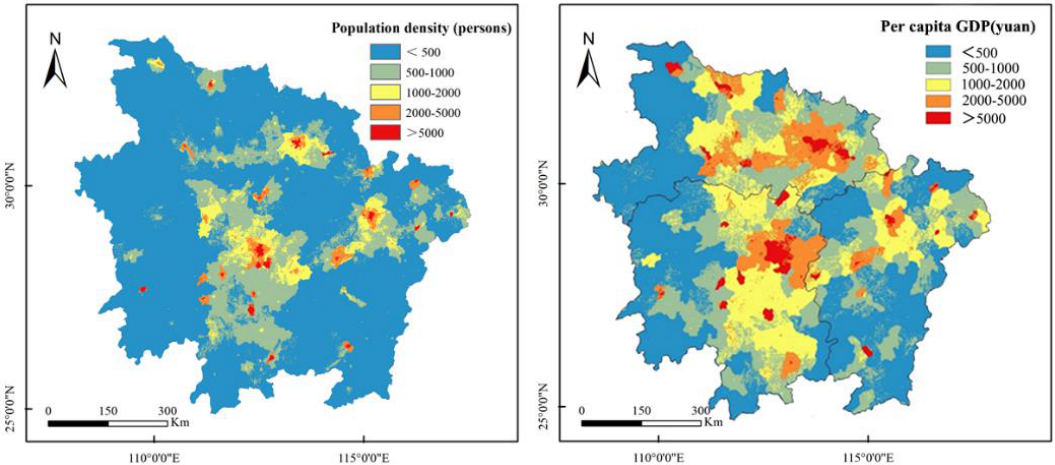
Figure 6. Population density and per capita GDP distribution in the middle reaches of the Yangtze River (MRYR). Table 7. Vegetation NDVI and population density distribution grades in the middle reaches of the Yangtze River (MRYR).